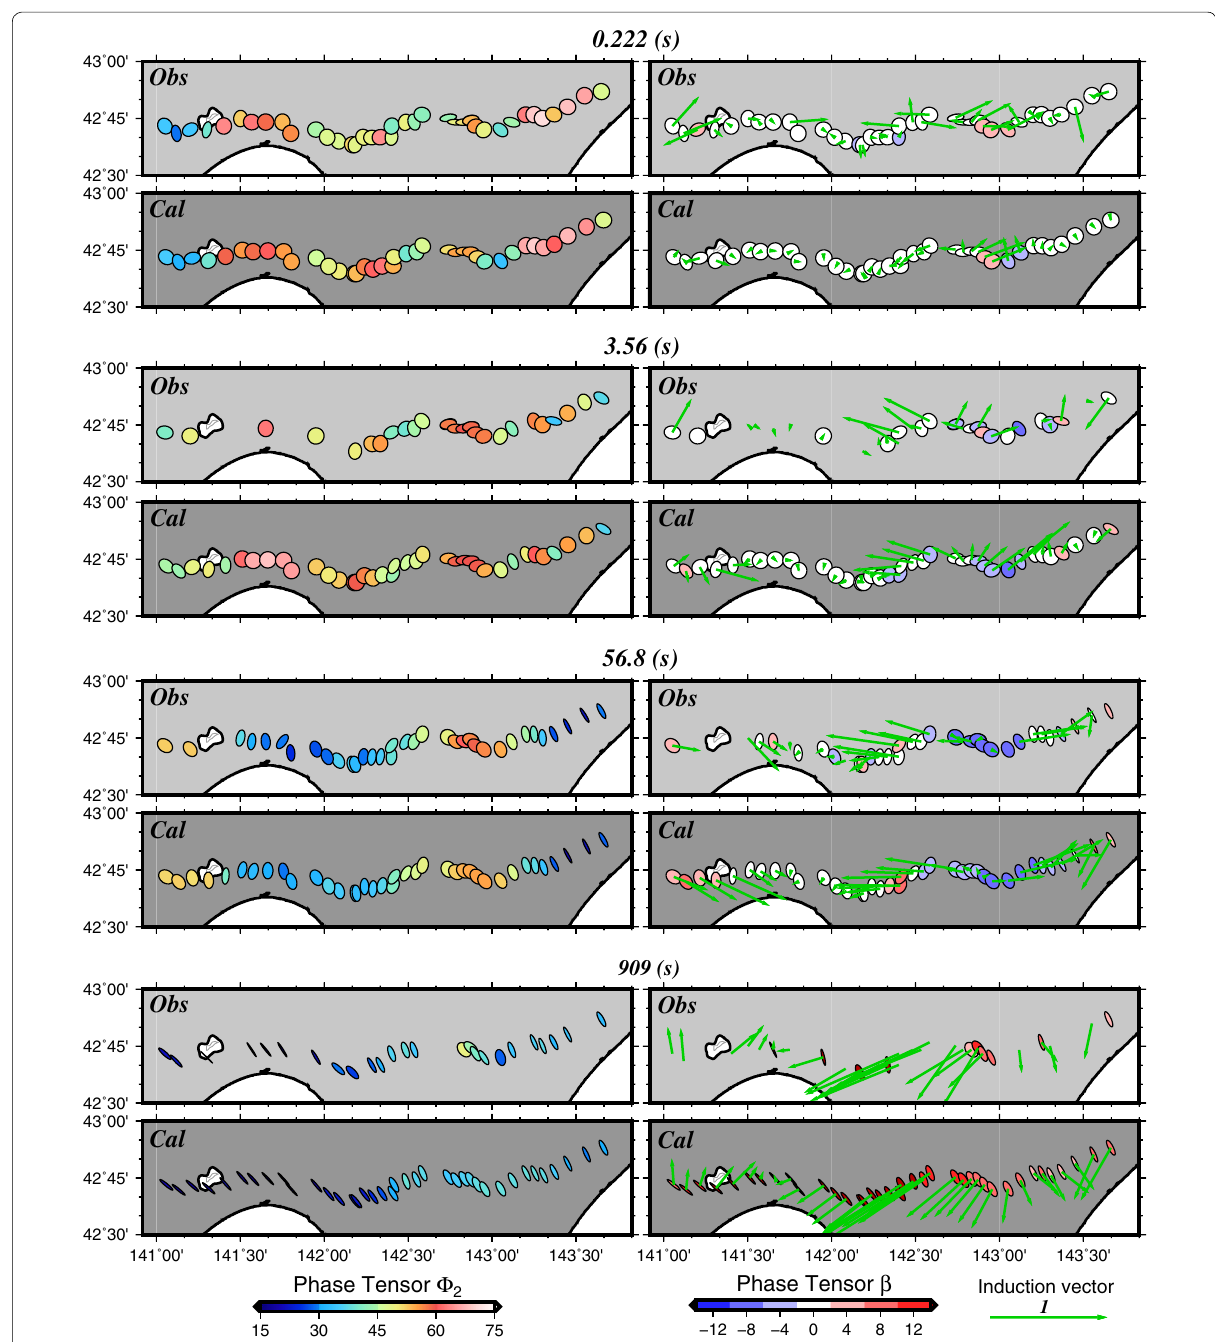
Fig. 3 Observed (OBS) and model-predicted (Cal) phase tensor ellipses and induction vectors. In the panels on the left, colored ellipses indicate Φ 2 of the phase tensor. Observed data with large errors ( Φ 2 > 10°) are not shown. In the panels on the right, colored ellipses indicate β of the phase tensor and green arrows are Parkinson’s induction vectors. Observed data with large errors ( β > 5°, amplitude of induction vectors > 0.05) are not